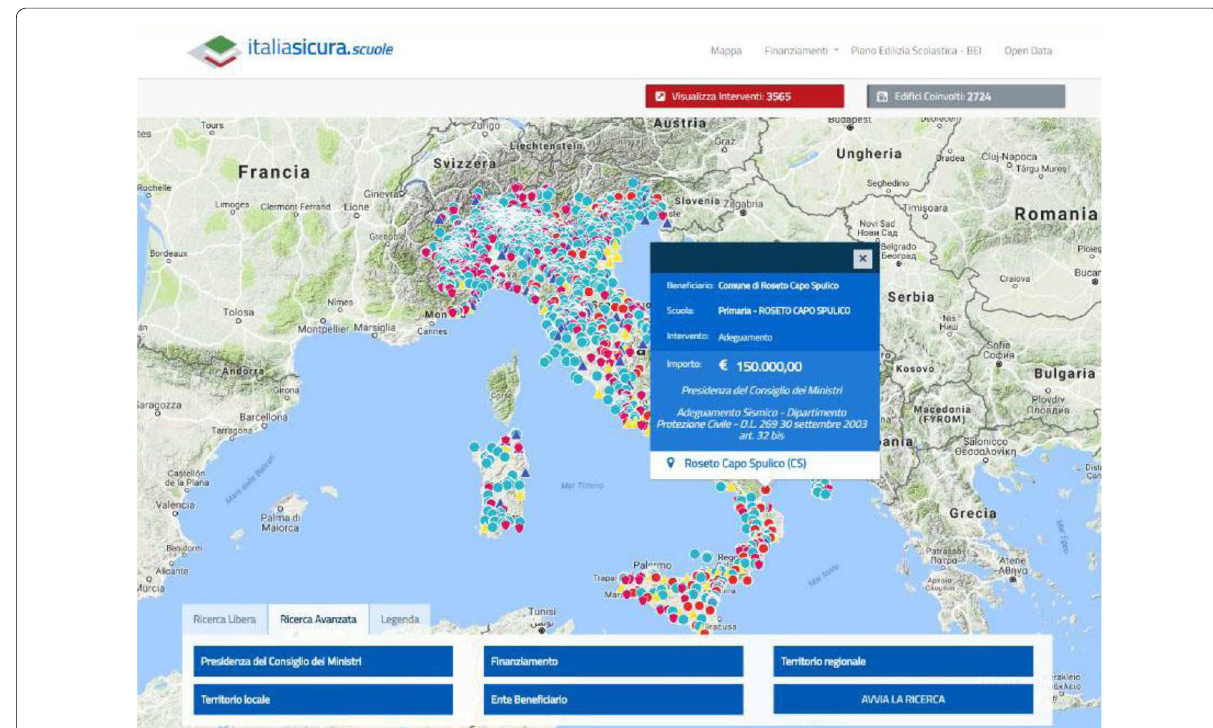
Fig. 3 ItaliaSicura Scuole, Schools with project search. (Source: Governo. ItaliaSicura Scuole. http://www.canti erisc uole.it Accessed 10 January 2018, the site has not been updated since the SMES closure, since January 2019 no longer available online)